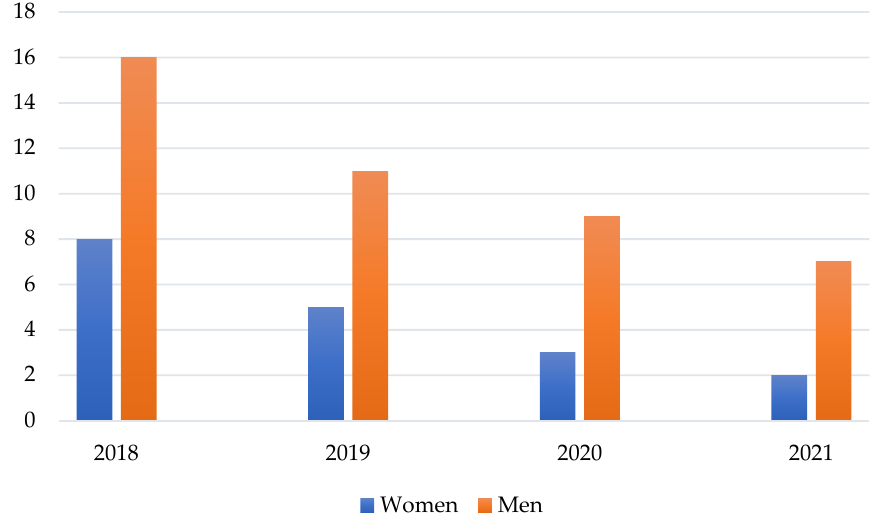
Figure 5. Gender of the participants.